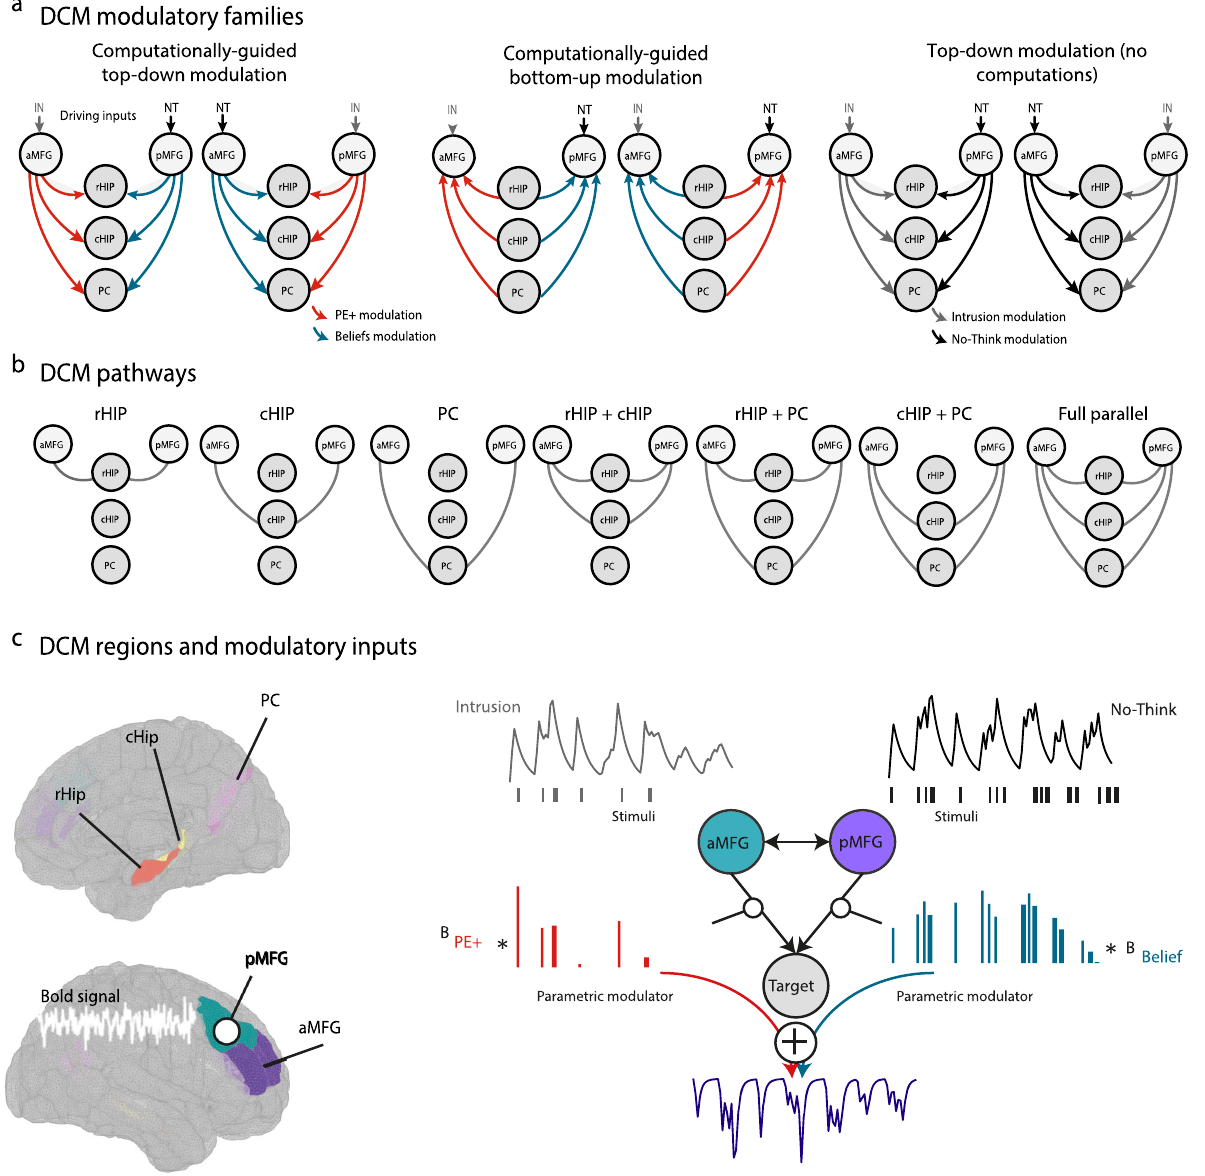
Fig. 3 DCM models. a DCM model families expressing different hypotheses on the involvement of intrusion beliefs and PE + computations in the modulation of the coupling between control regions (anterior and posterior middle frontal gyrus, MFG) and memory target regions, including the rostral hippocampus (rHIP), caudal hippocampus (cHIP), and precuneus (PC). It should be noted that null models were also estimated, but are not shown here. b Pathways capturing the seven possible connections between control and target regions. c Left panel shows the regions of interest used for DCM analysis. Right panel provides an illustration of the modularity inputs in fl uencing the connectivity between brain